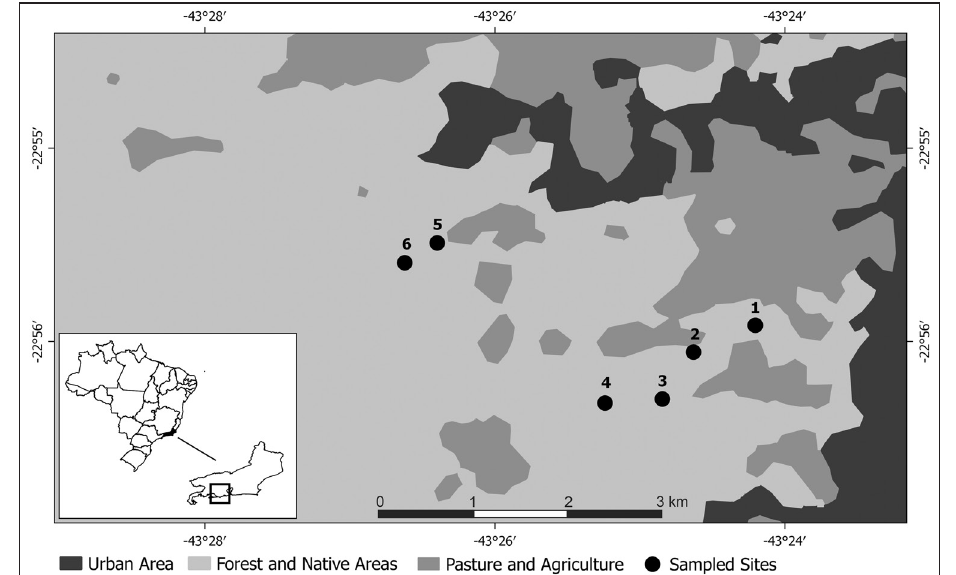
Figure 1. Map of the study area indicating the sampling localities in CFMA and Pau da Fome region, State of Rio de Janeiro, Brazil. 1) CFMA – Peridomicile, 2–3) CFMA – Disturbed Forest, 4) CFMA – Preserved Forest, 5) Pau da Fome – Peridomicile, 6) Pau da Fome –